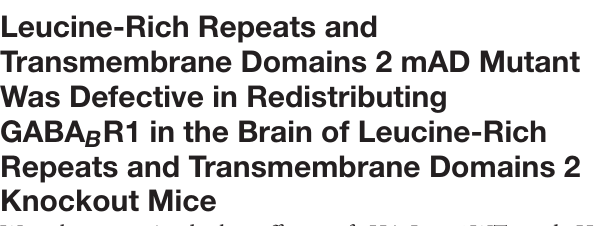
neurites shapes ( Supplementary Figure 12 ) of the transfectants. HA-Lrtm2 increased the axon and dendrite areas (axon, t = 4.43, p = 0.00011, Welch’s t -test; dendrite, t = 3.40, p =